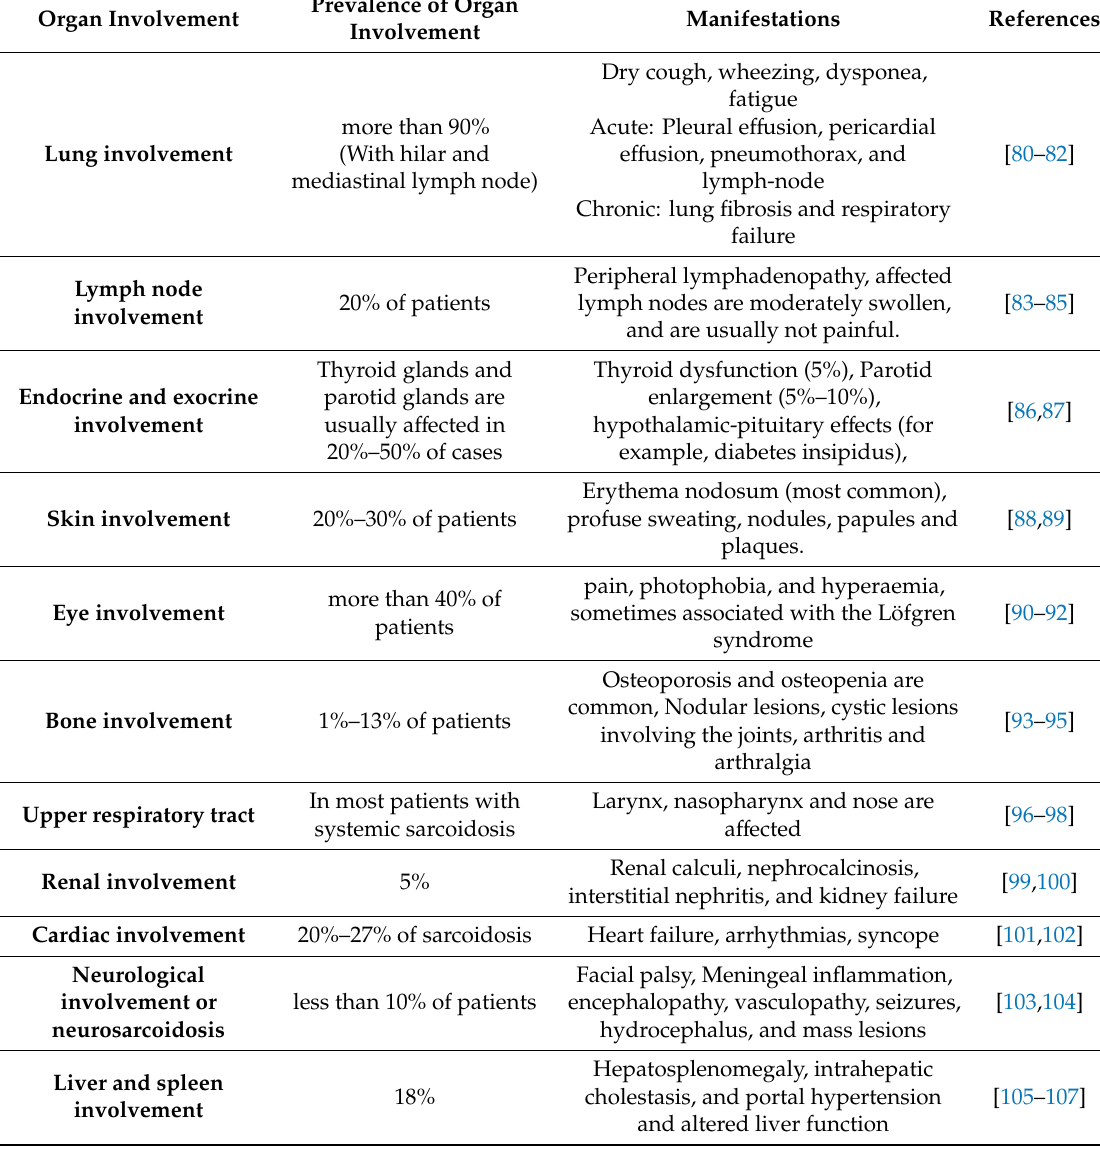
Table 1. List of organs involved in